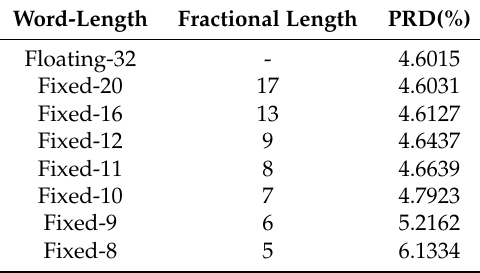
Table 6. Word-length